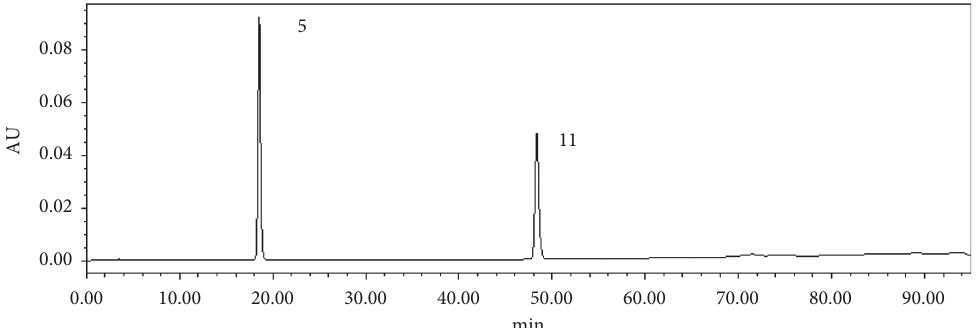
Figure 2: The chromatogram of the mixed reference substance.